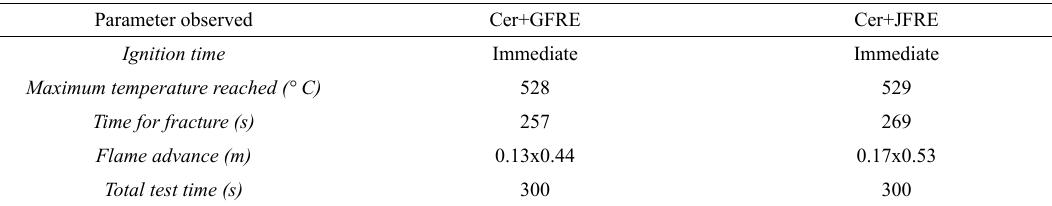
Table 4. Parameters observed in the flame propagation test